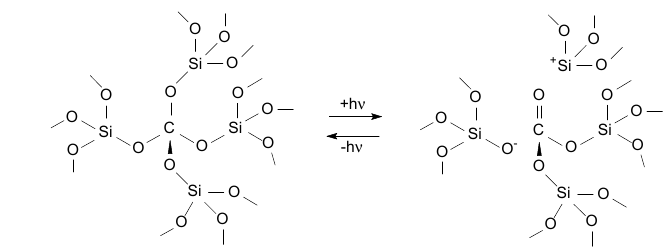
Scheme 2. Interaction of citric acid with ethoxysilyl